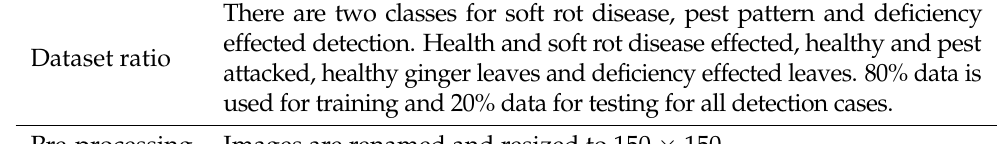
Table 6. Hyper parameters tuning used for